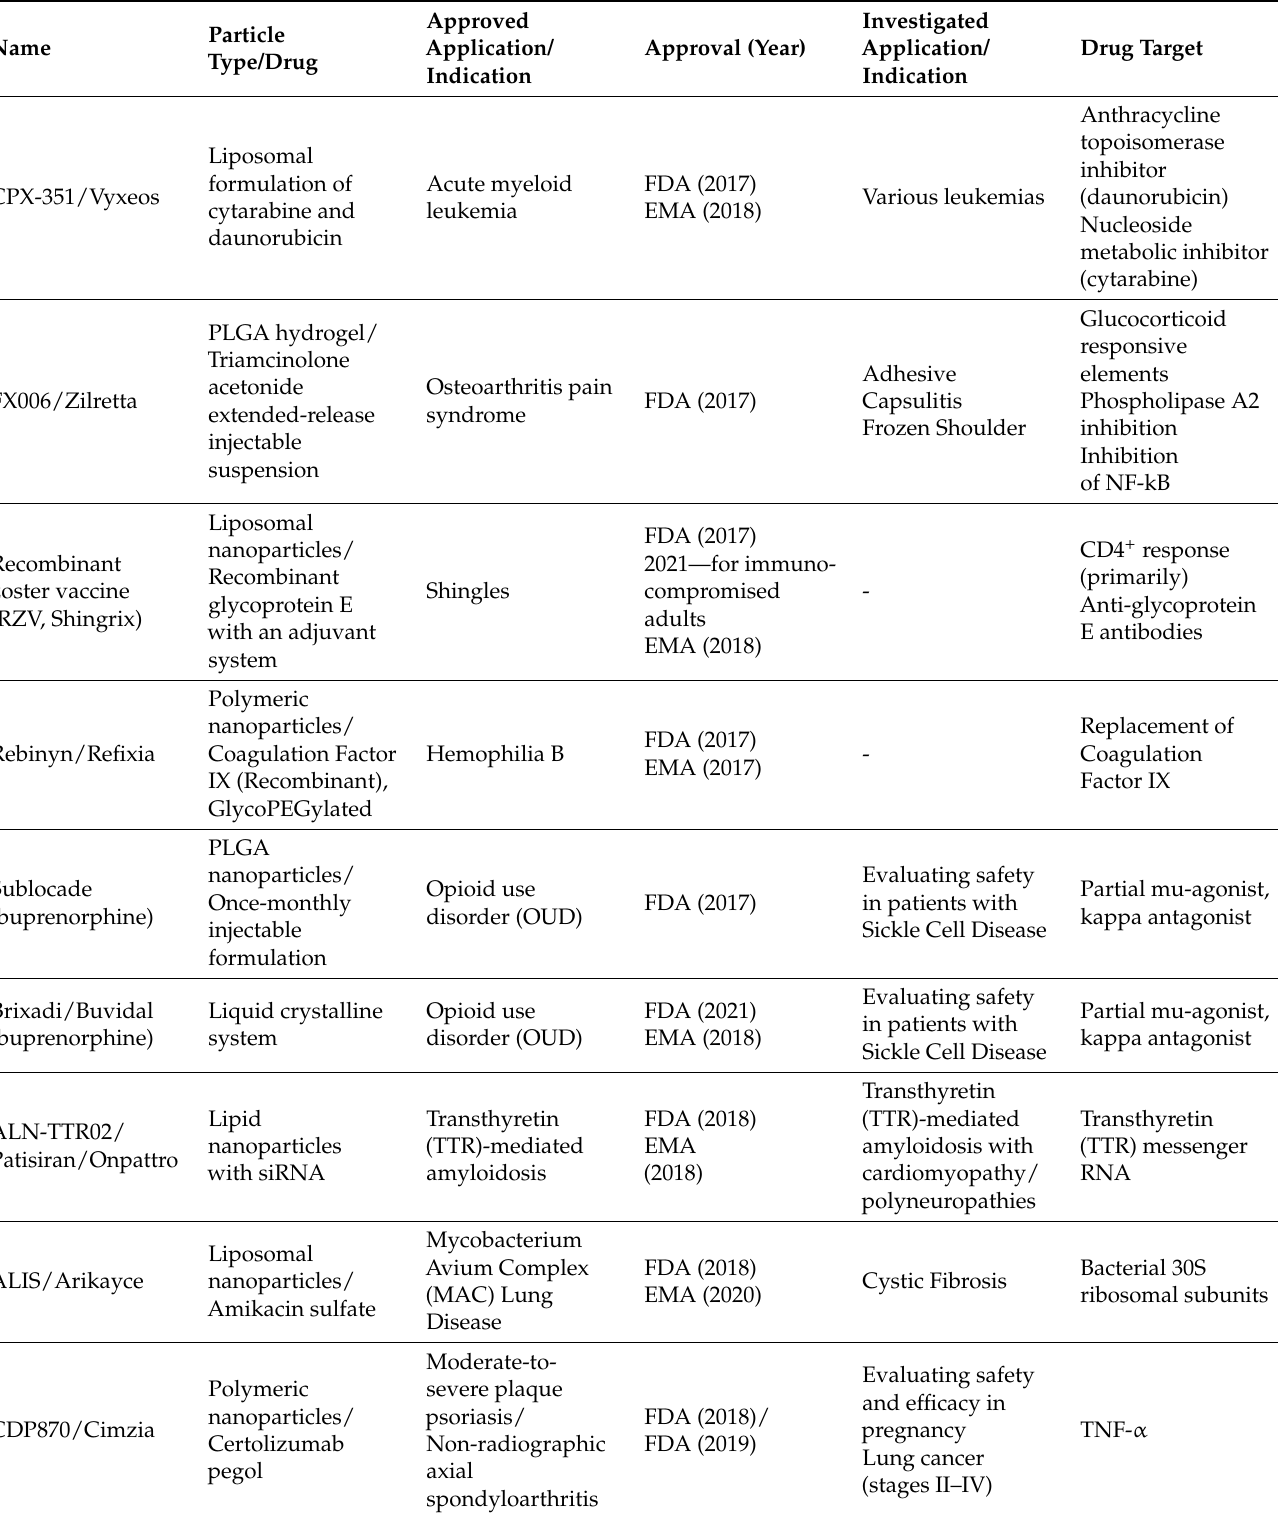
Table 1. FDA-approved drugs since 2016. PLGA—poly-(d,l-lactic acid-co-glycolic acid),